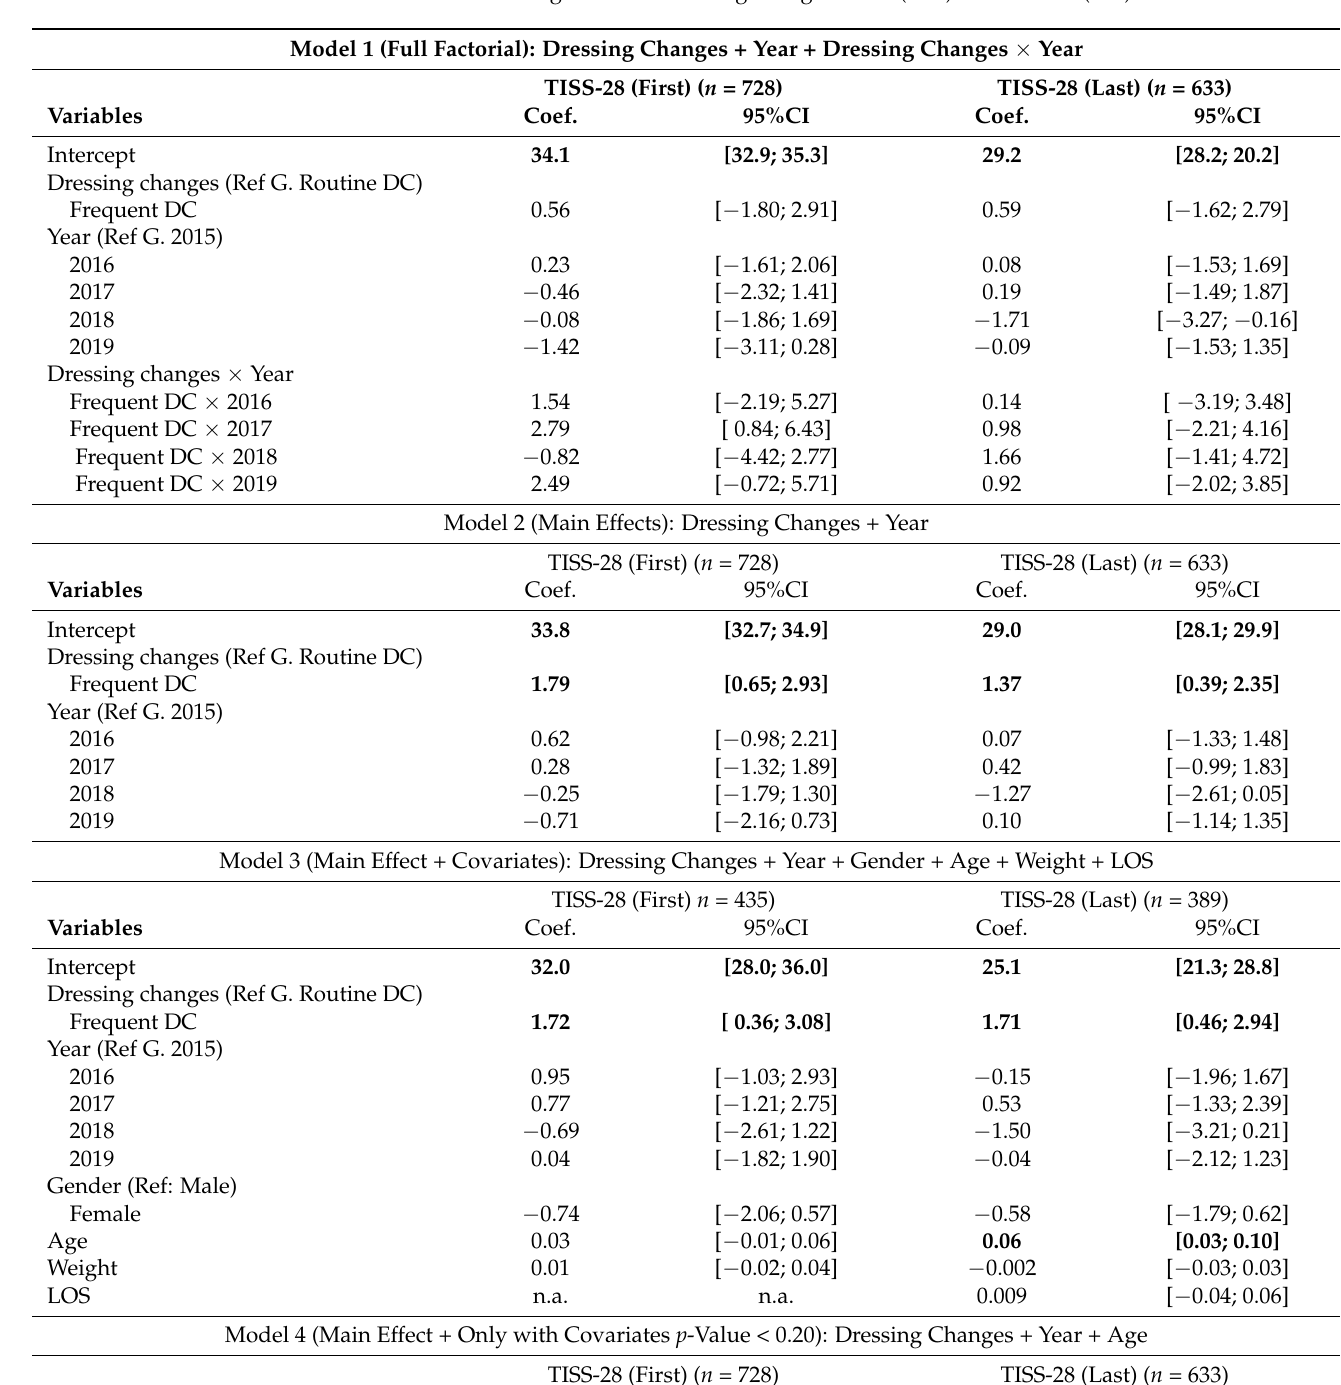
Table A3. Linear regression models regarding TISS-28 (first) and TISS-28